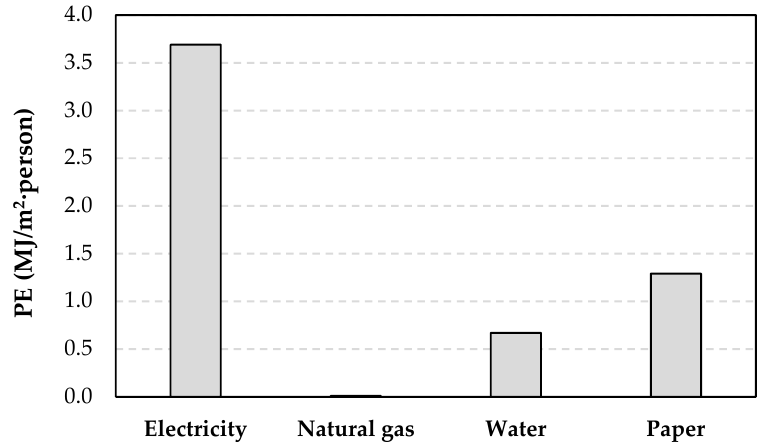
Figure 7. Contribution of the different flows to the total primary energy (PE).